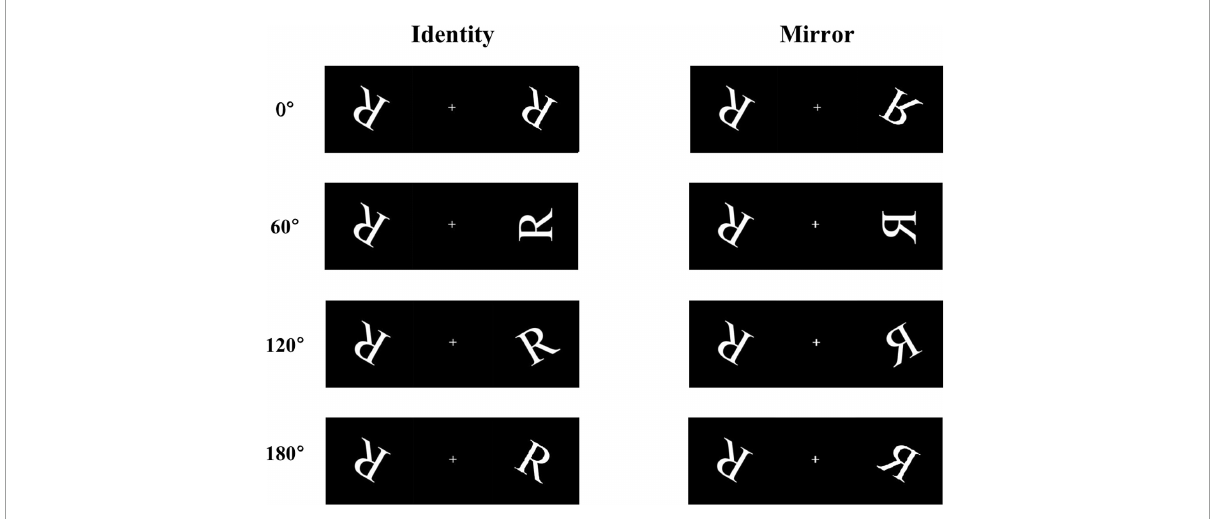
FIGURE1 Some examples of the stimulus materials, including four angles of rotation (0 ◦ , 60 ◦ , 120 ◦ , and 180 ◦ ), under two conditions (identical and mirror letters).